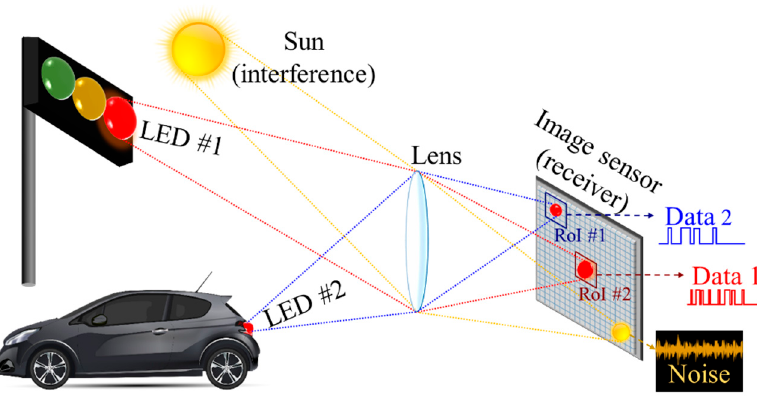
Figure 32. Spatial separation of multiple sources using an image sensor.